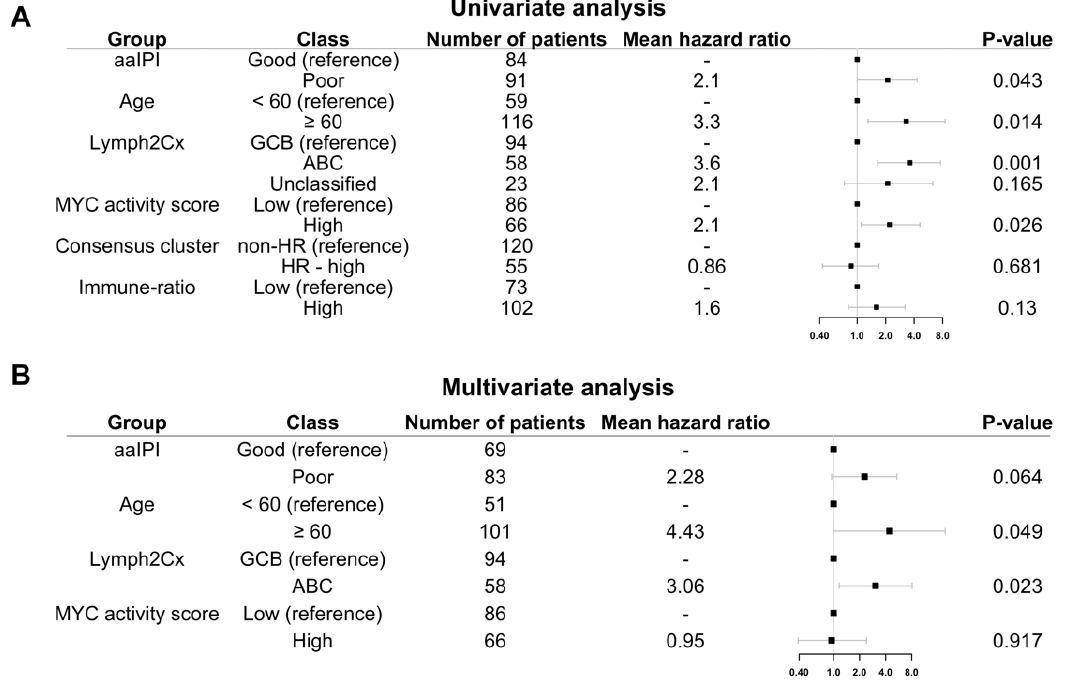
Figure 6. Five-year OS of HOVON-84 patients: ( A ) Forest plot with the univariate effect of the clinical variables and GEP signatures. ( B ) Forest plot with the multivariate effect of clinical variables and GEP signatures. In this cohort, only the COO as defined by the Lymph2Cx remains significant.